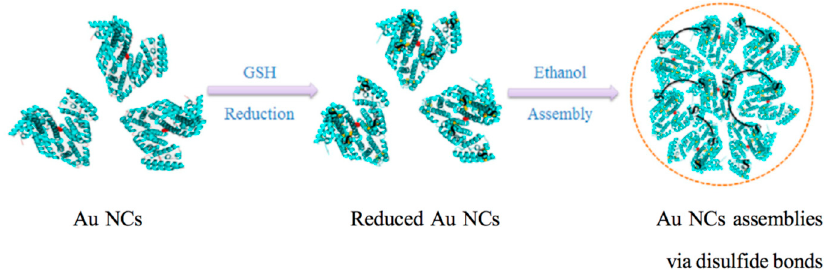
Figure 4. Schematic illustration for the self-assembly of protein-capped Au NCs by a protein cross-linking approach. Adapted with permission from Ref. [40]. Copyright (2017) Elsevier.